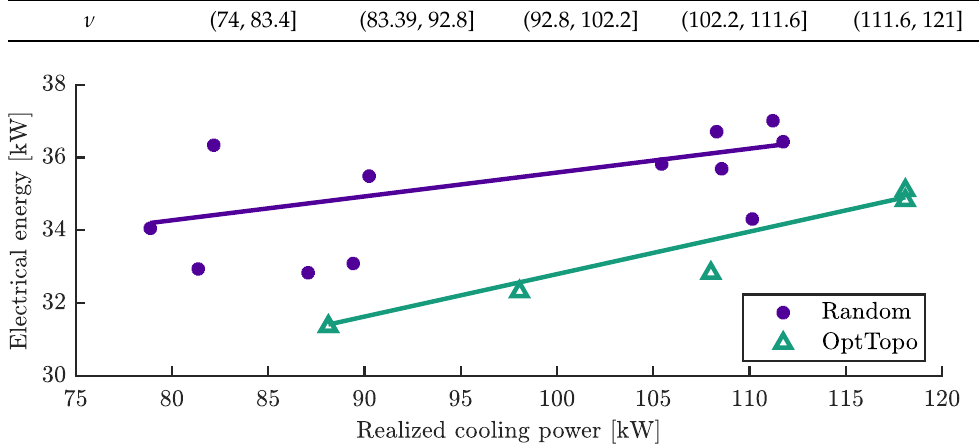
Table 3. Five intervals of cooling power are defined as requests to the overall system.